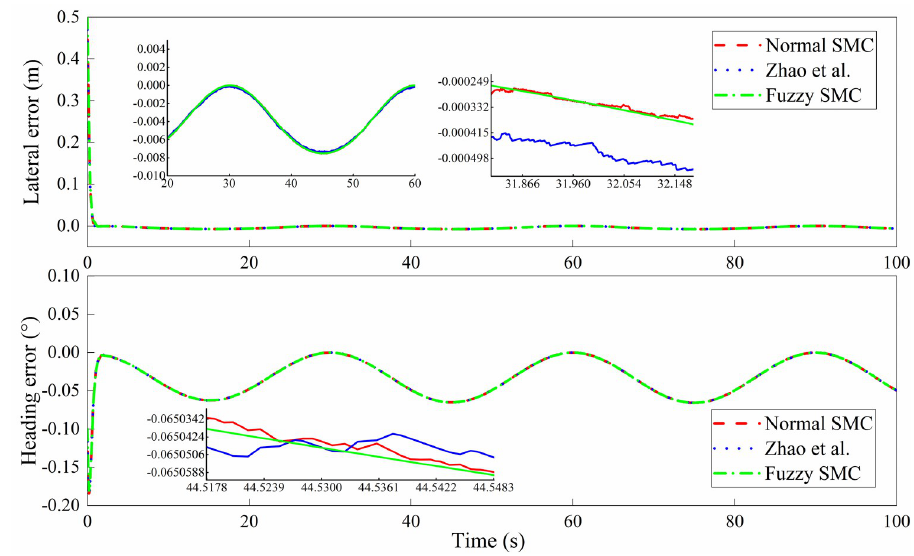
Fig 17. Lateral error, heading error with continuous channel change.